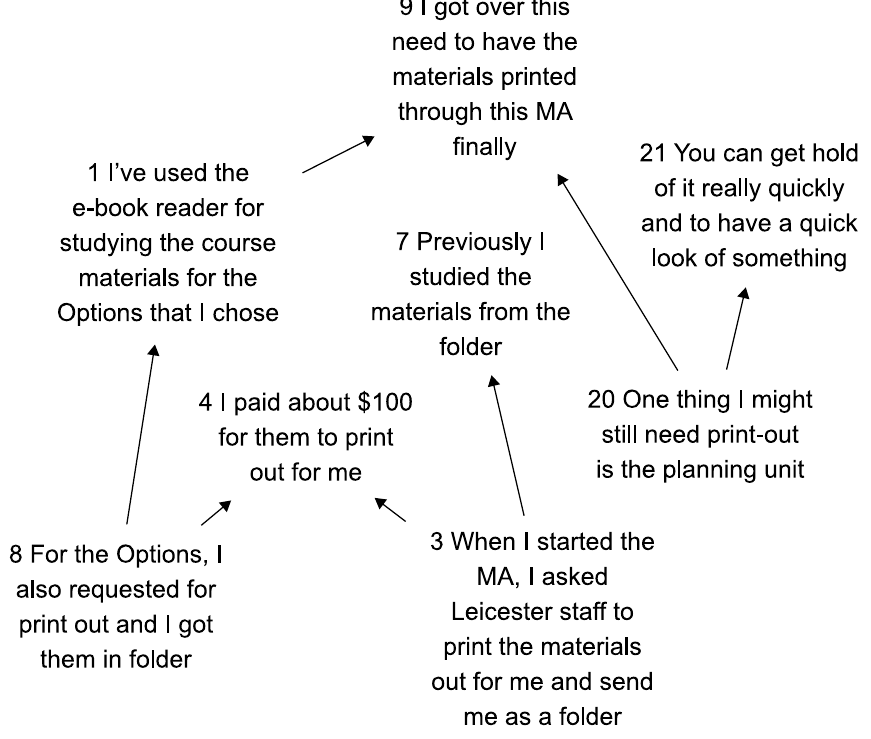
Figure 5. Cost saving for